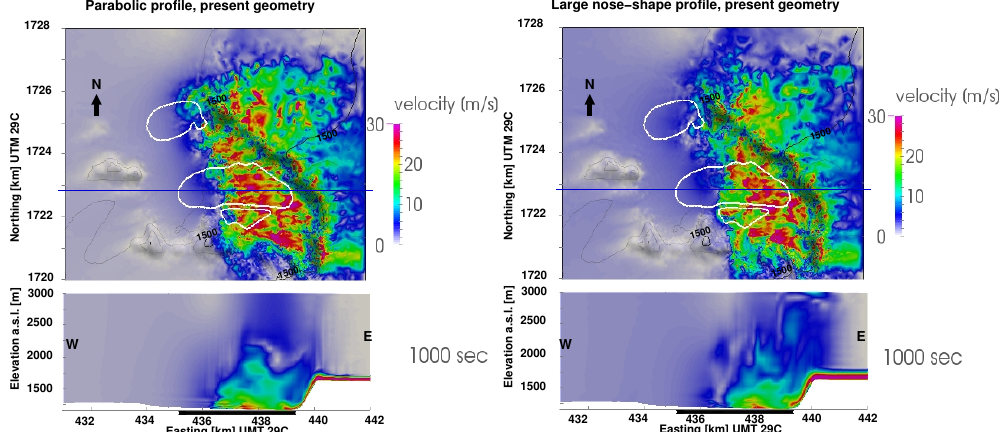
Figure 10. Velocity magnitude 5m above the surface and in a vertical cross section from east to west through the valley (marked by the horizontal blue line in plan views) of the simulations using the parabolic (Eq. 6) and the upscaled nose profile (Eq. 7) displayed at 1000s into the simulation. The white lines in the plan views and the black bar under the cross sections denote the positions of the BIAs. The cross sections are stretched vertically by a factor of 2. The velocity scales are truncated at 30ms − 1 .